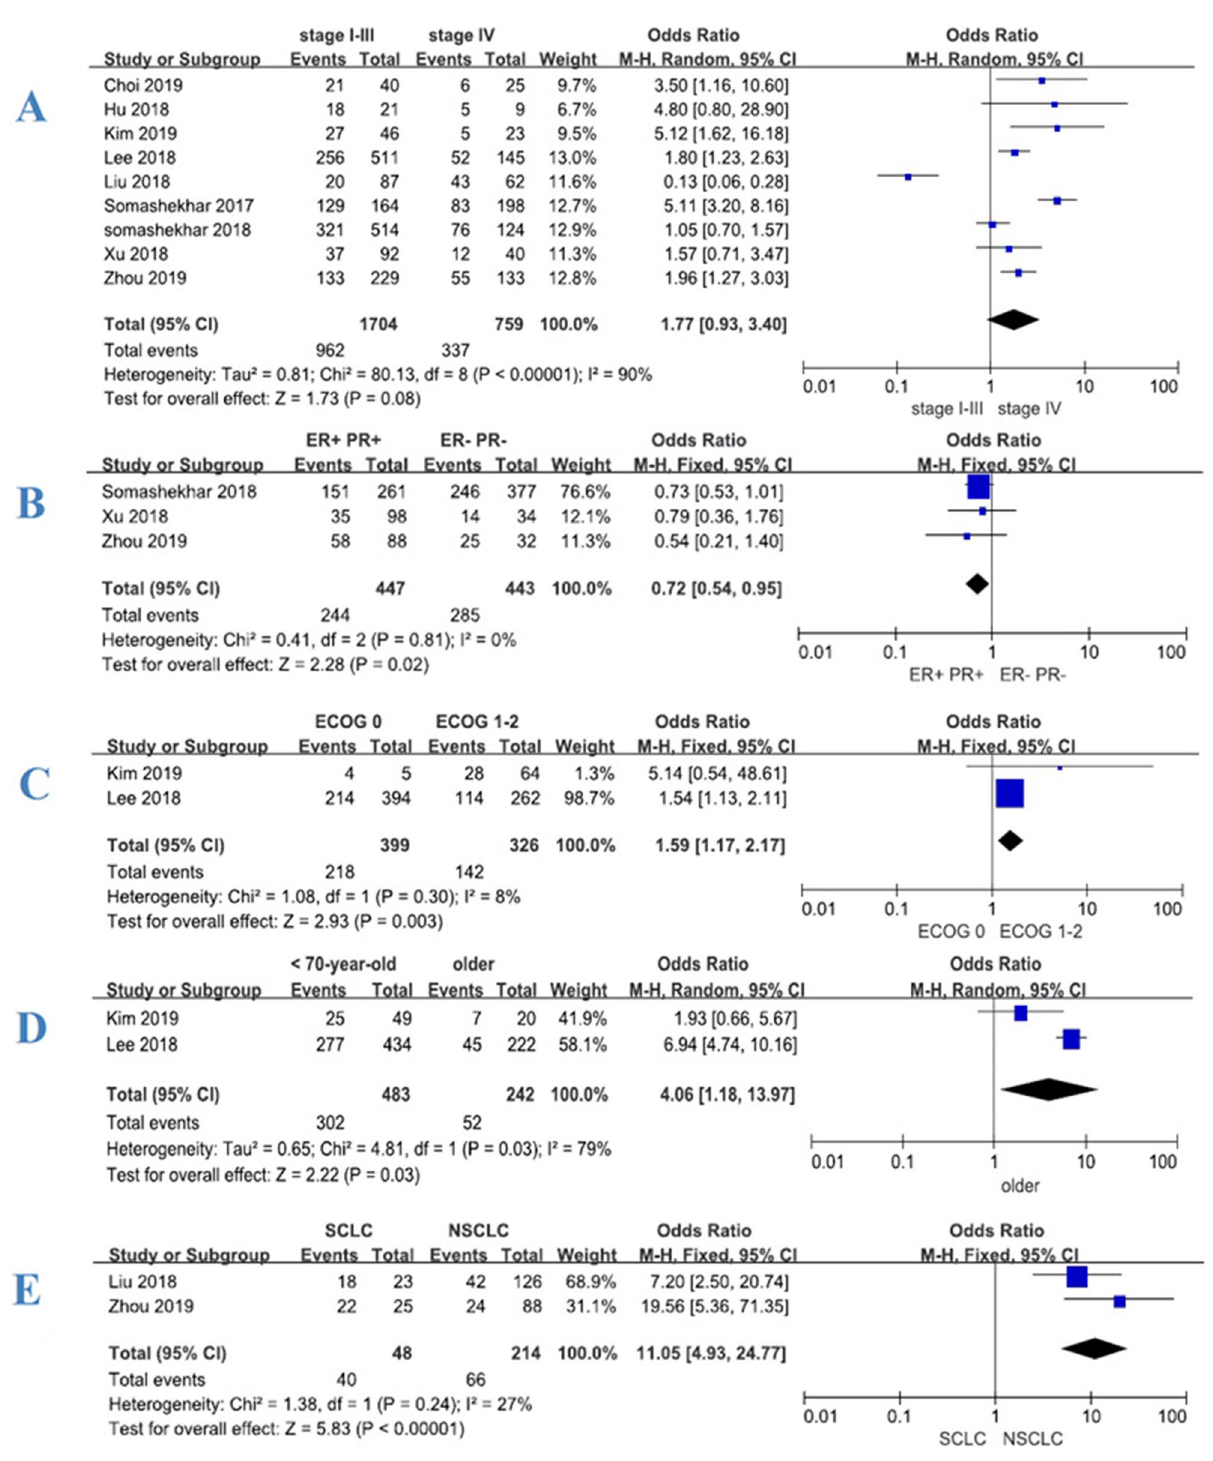
Figure 3. Forest plot of consistency between WFO (only ‘Recommended’) and MDT for patients with various cancers. Treatment was considered concordant if the delivered treatment was rated as ‘Recommended’ by WFO and discordant if the delivered treatment was rated as other options by WFO or was physician’s choice (not included in WFO). Overall concordance of various cancers in stages I–III and IV ( A ). Concordance of various estrogen and progesterone receptors (ER+/PR+vs. ER−, PR−) in breast cancer ( B ). Concordance of various performance status (ECOG 0 vs. ECOG 1–2) in colorectal cancer ( C ). Concordance of various age (< 70-year- old vs. older) in colorectal cancer ( D ). Concordance of various pathological types (small cell vs. non-small cell) in lung cancer ( E